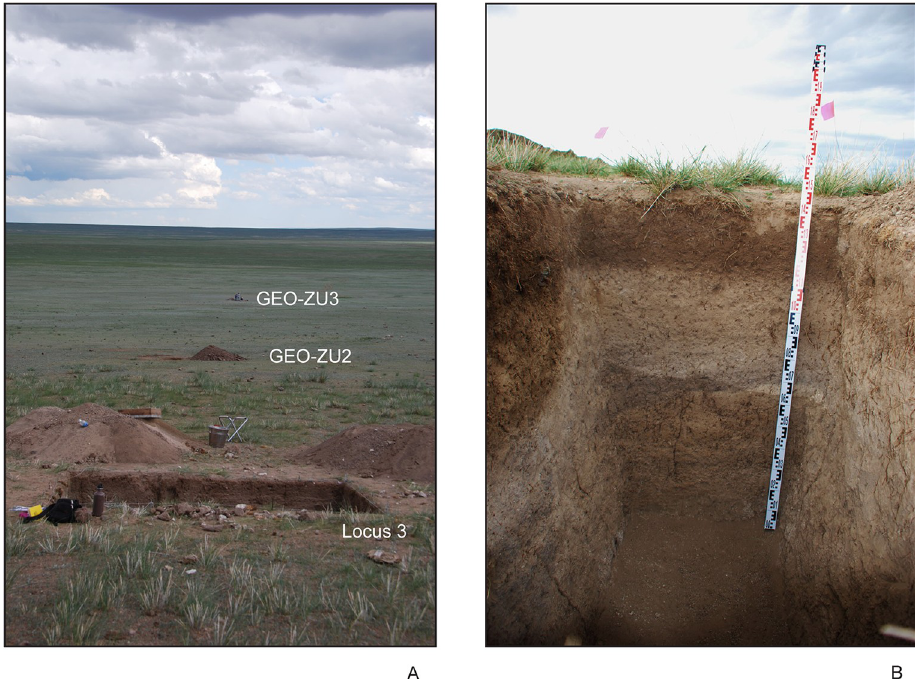
Fig 8. (A) Excavation of Locus 3 (ZU3.T1) and location of geopits GEO.ZU2 and GEO.ZU3 relative to Locus 3. (B) view of intact stratigraphy at Zaraa